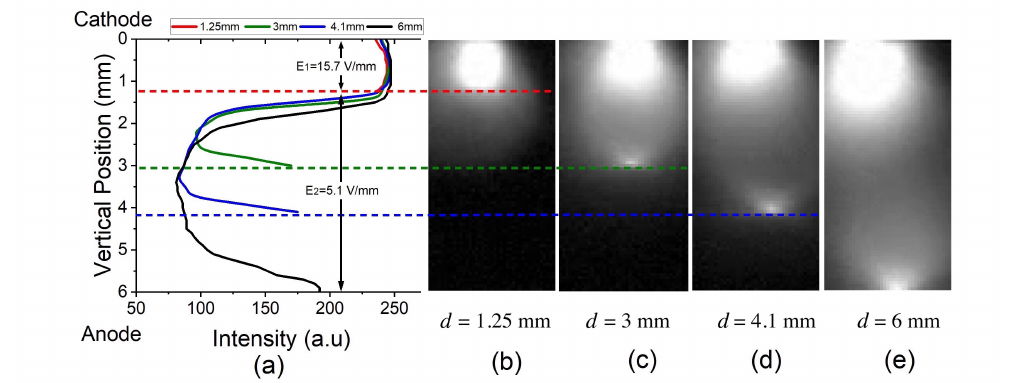
Figure 14. ( a ) Maximum radiation intensity as a function of the vertical position for the Type-1 contacts at an arc current I = 8.1 A; ( b ) through ( e ) images of the arc development for different distances or positions d . The dashed lines show the different anode positions for images ( b – d ) in accordance with the colour legend given above ( a ) to distinguish the intensity curves for each